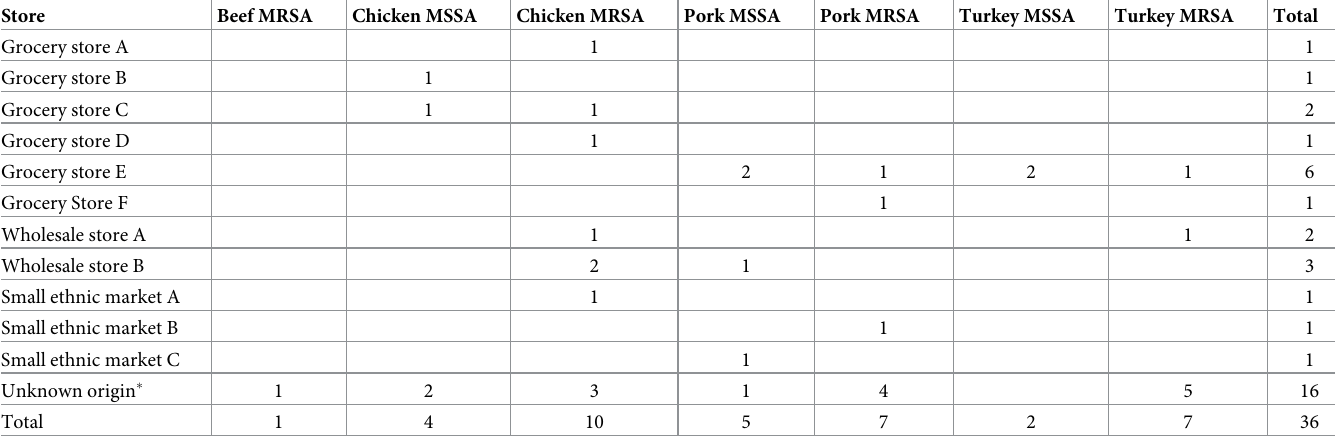
Table 1. Origin of Staphylococcus aureus isolates (conventional meats) by store location.